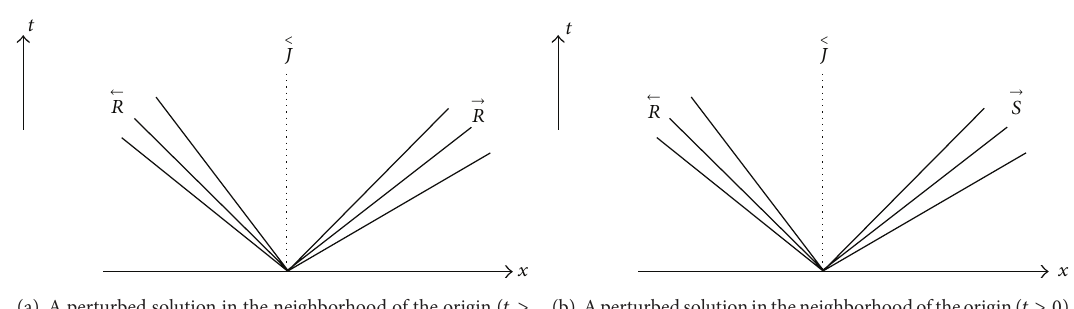
Figure 7: Solutions in Case 1.